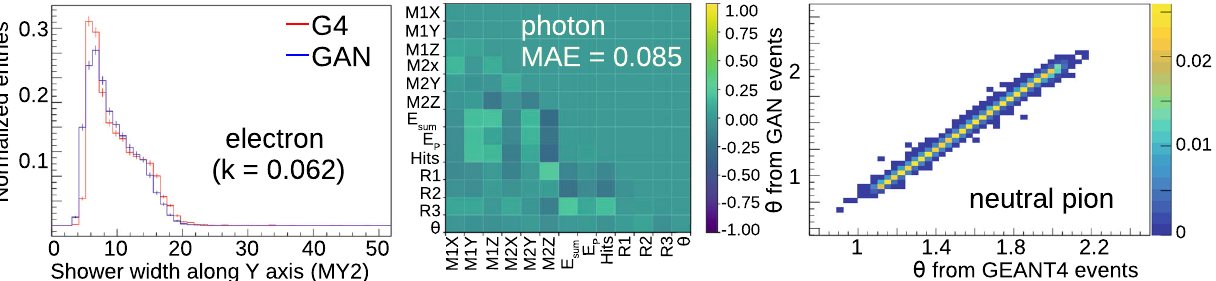
Fig. 9 The GAN vs. GEANT4 shower features. (Left) the shower width(M2)alongthe Y axisforelectrons(kdenotesp-valuefortheKol- mogorov test). (Mid) difference between internal correlations present